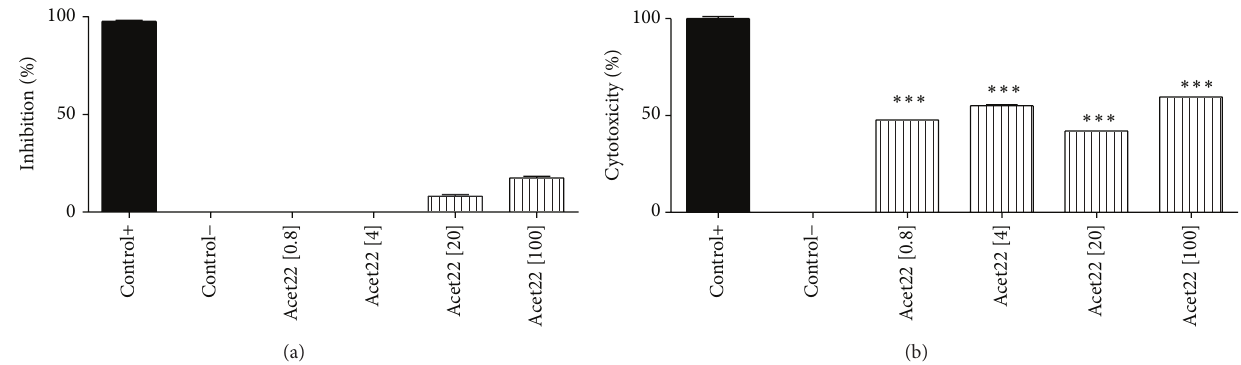
Figure 5: (a) Inhibitory effect of Mycobacterium bovis BCG growth by Acet22 (isoquercitrin) tested at four different concentrations, 0.8, 4, 20, and 100 𝜇 g/mL. The percentage of inhibition was compared with the positive control (rifampicin), 98.17 ± 0.8 % / O . D.: 0.180 ± 0.8 , and negative control (medium + mycobacteria), 0.1 ± 0.1 % / O . D.: 0.880 ± 1.24 . (b) Cytotoxicity of Acet22 (isoquercitrin) tested at four different concentrations 0.8, 4, 20, and 100 𝜇 g/mL in murine macrophages RAW 264. The percentages were compared to positive control, macrophages treated with Triton 1%: 98.88 ± 1.6/ O . D.: 0.132, and negative control, macrophages without treatment 0.01 ± 0.1/ O . D.: 0.749. ∗ 𝑃 < 0.05 , ∗∗ 𝑃 < 0.01 , and ∗∗∗ 𝑃 < 0.001 , significance obtained by ANOVA and posttest Tukey ( 𝑛 = 3 ), when compared to the negative control (a) and positive control (b).